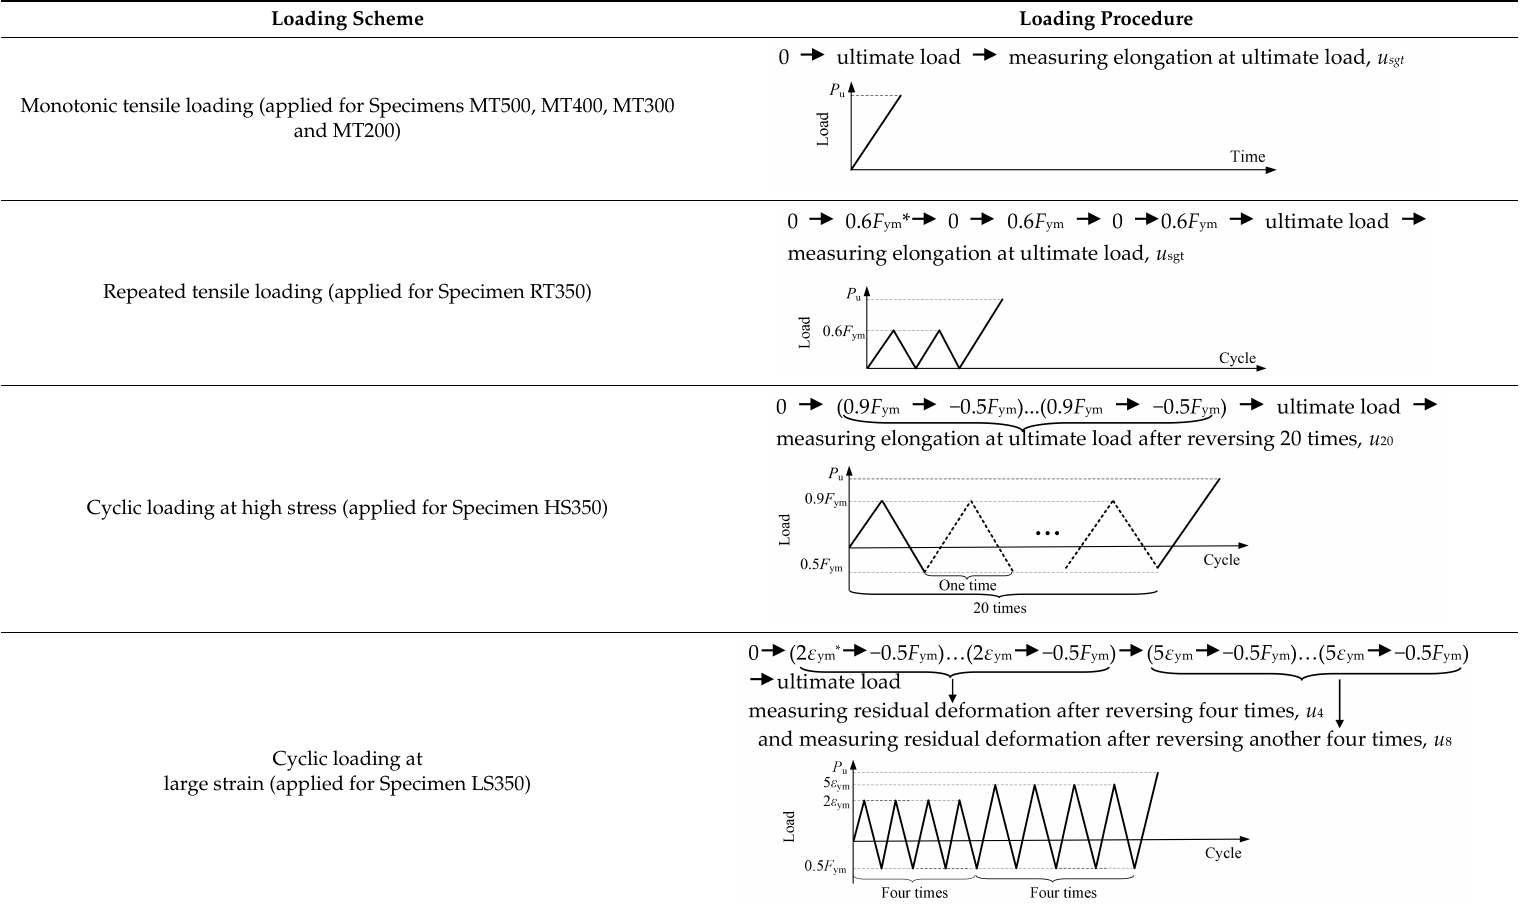
Table 4. Loading procedures for di ff erent loading